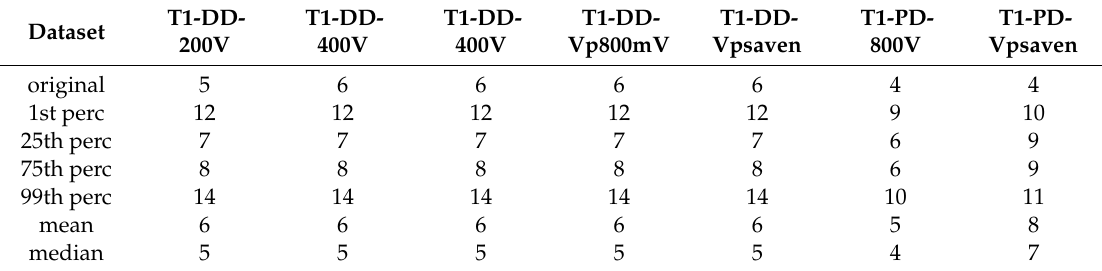
Table 4. Number of iterations, for each original and simulated dataset (1st percentile, 25th percentile, 75th percentile, 99th percentile, mean, and median), to reach the inversion model